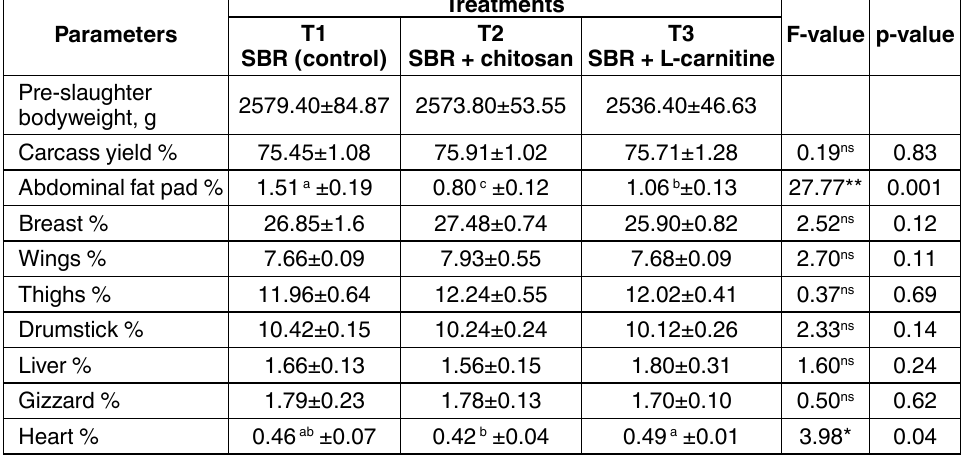
Table 2. Effect of dietary treatments on carcass characteristics of broilers at six weeks of age Parameters